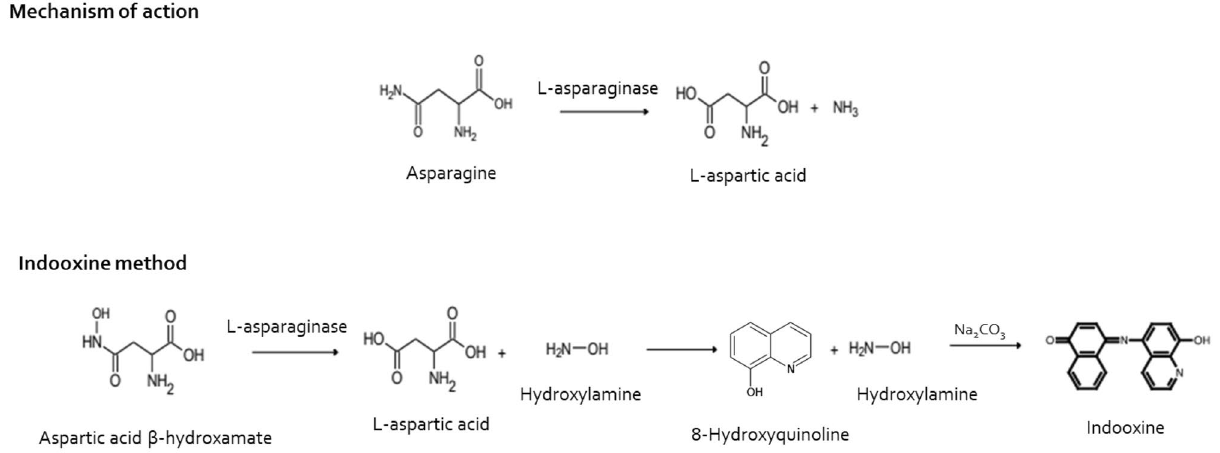
Figure 1. Mechanism of action of asparaginase and reaction of the indooxin method, based on the hydrolysis of l-aspartic b-hydroxamate (AHA), to determine enzyme activity. Figure adapted from Lanvers et al. 10